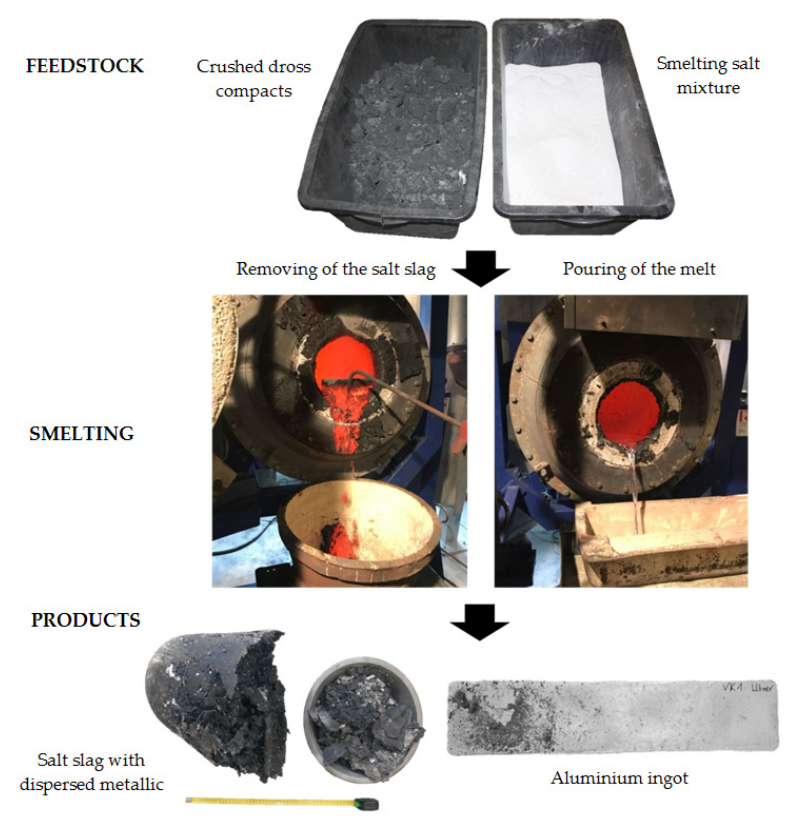
Figure 4. Process sequence for the melting experiment of the dross with a salt slag in the